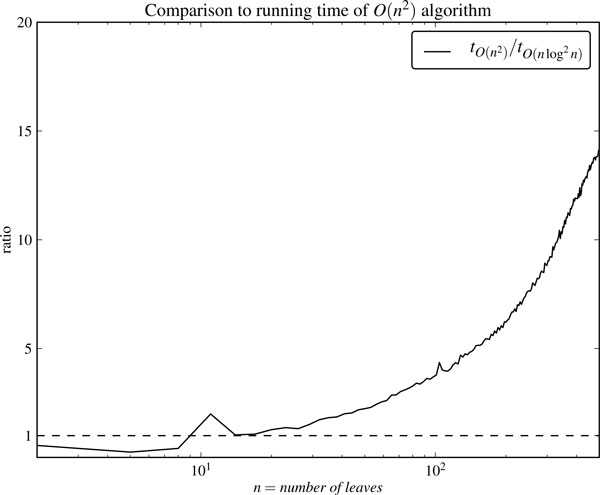
Comparison to O(n2) algorithm. Ratio between the running times for the O(n2) time algorithm and the O(n log2 n) time algorithm.